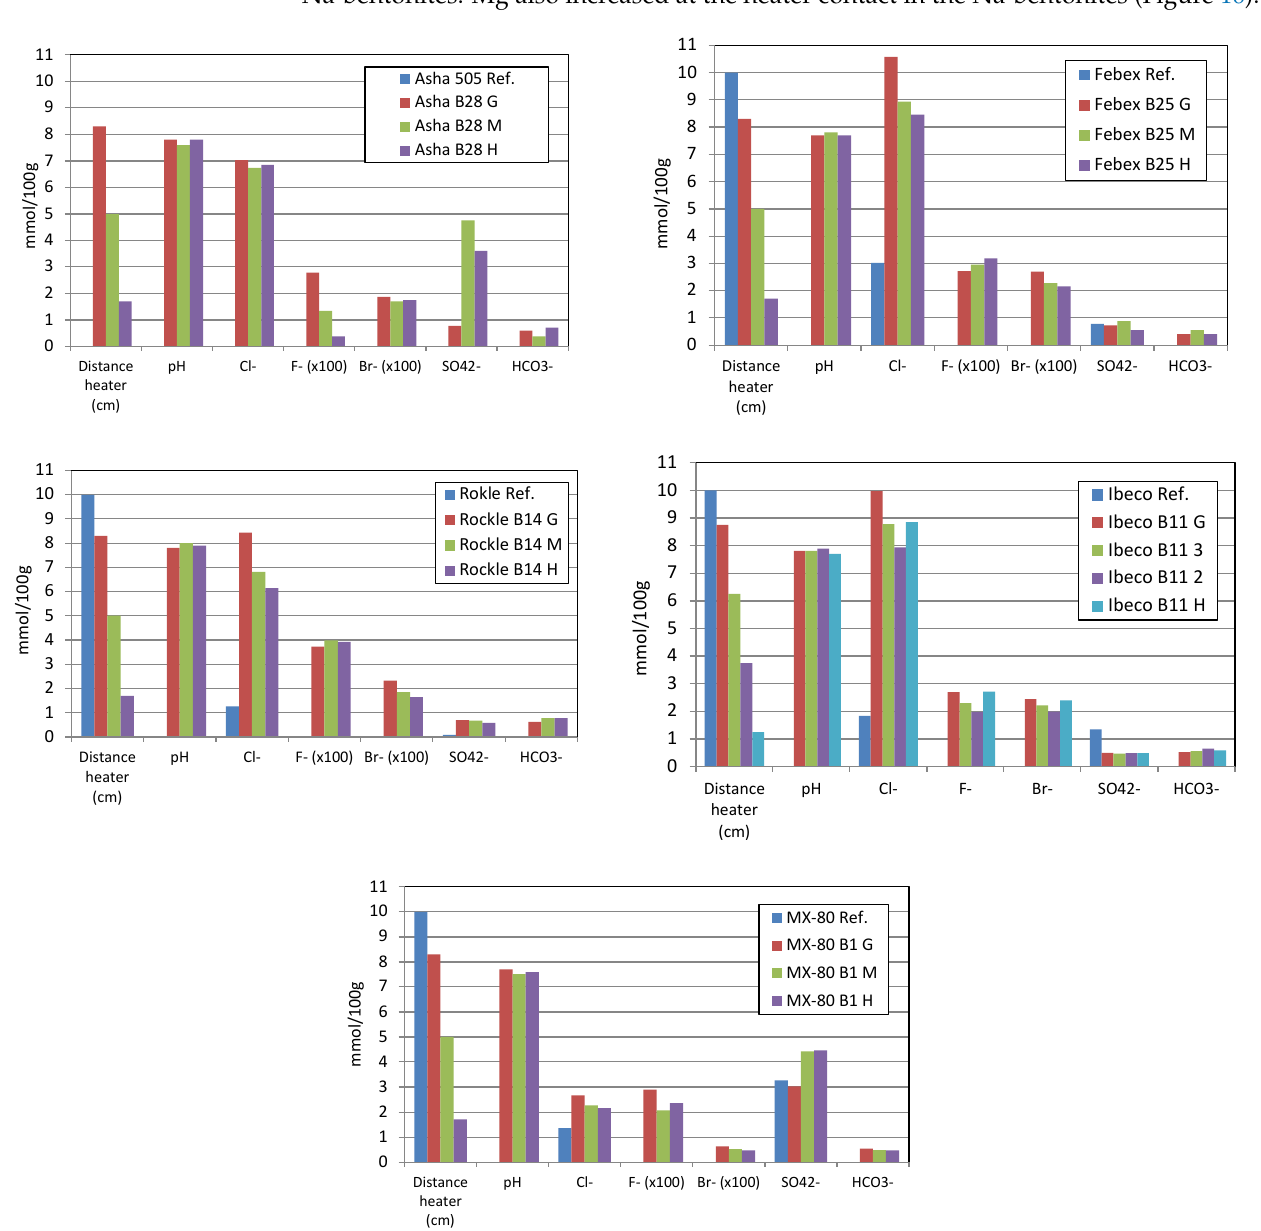
Figure 15. Anion distribution as a function of the heating contact obtained from leaching tests (in mmol/100 g). Reference data for chloride and sulfate are given for comparison.